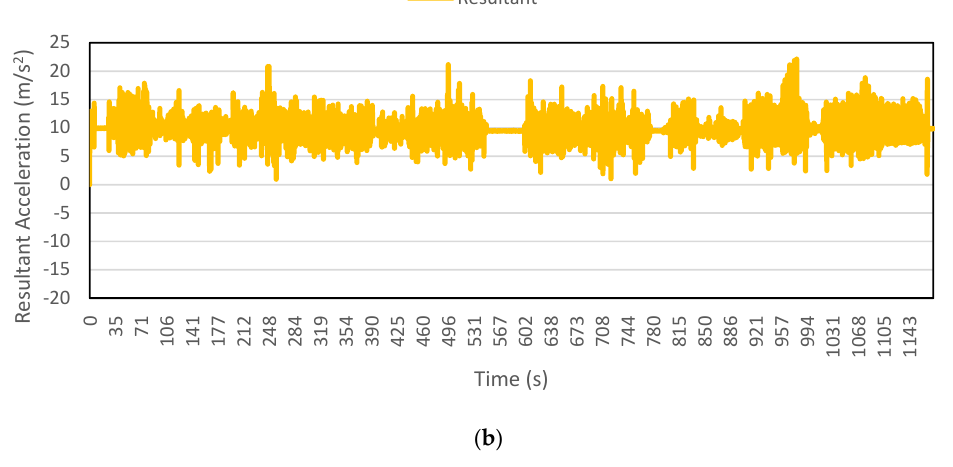
Figure 3. Accelerations recorded for a bicycle trip: ( a ) Accelerations along three axes; and ( b ) Resultant acceleration.